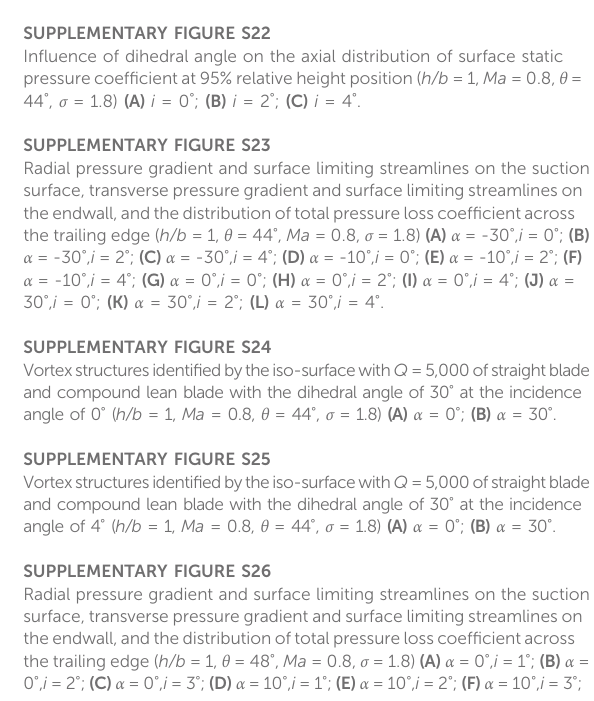
SUPPLEMENTARY FIGURE S16 In fl uence of solidity and dihedral angle on incidence characteristics of total pressure loss coef fi cient and diffusion factor with different camber angels ( h/b = 1, Ma = 0.8) (A) θ = 40 ° , α = 0 ° ; (B) θ = 40 ° , α = 20 ° ; (C) θ = 40 ° , α = 30 ° ; (D) θ = 44 ° , α = 0 ° ; (E) θ = 44 ° , α = 20 ° ; (F) θ = 44 ° , α = 30 ° ; (G) θ =48 ° , α =0 ° ; (H) θ =48 ° , α =20 ° ; (I) θ =48 ° , α =30 ° ; (J) θ =50 ° , α =0 ° ; (K) θ = 50 ° , α = 20 ° ; (L) θ = 50 ° , α = 30 ° . SUPPLEMENTARY FIGURE S17 Axial distribution of surface static pressure coef fi cient at 50% relative height position at different solidities ( h/b = 1, Ma = 0.8, θ = 44 ° ) (A) i = 1 ° ; (B) i = 2 ° . SUPPLEMENTARY FIGURE S18 Radial pressure gradient and surface limiting streamlines on the suction surface, transverse pressure gradient and surface limiting streamlines on the endwall, and the distribution of total pressure loss coef fi cient acrossthetrailingedge( h/b =1, θ =44 ° , Ma =0.8) (A) i =1 ° , σ =1.4; (B) i = 1 ° , σ = 1.8; (C) i = 1 ° , σ = 2.2; (D) i = 2 ° , σ = 1.4; (E) i = 2 ° , σ = 1.8; (F) i = 2 ° , σ = 2.2. SUPPLEMENTARY FIGURE S19 In fl uence of dihedral angle on incidence characteristics of total pressure loss coef fi cient with different camber angels ( h/b = 1, Ma = 0.8, (A) σ = 1.8) θ = 40 ° ; (B) θ = 44 ° ; (C) θ = 48 ° . SUPPLEMENTARY FIGURE S20 Radial pressure gradient and surface limiting streamlines on the suction surface, transverse pressure gradient and surface limiting streamlineson theendwall,andthedistributionoftotalpressurelosscoef fi cientacross the trailing edge ( h/b = 1, θ = 40 ° , Ma = 0.8, σ = 1.8) (A) α = 0 ° , i = 0 ° ; (B) α = 0 ° , i =2 ° ; (C) α =0 ° , i =4 ° ; (D) α =10 ° , i =0 ° ; (E) α =10 ° , i =2 ° ; (F) α =10 ° , i =4 ° ; (G) α = 20 ° , i = 0 ° ; (H) α = 20 ° , i = 2 ° ; (I) α = 20 ° , i = 4 ° ; (J) α = 30 ° , i = 0 ° ; (K) α = 30 ° , i = 2 ° ; (L) α = 30 ° , i = 4 ° . SUPPLEMENTARY FIGURE S21 In fl uence of dihedral angle on the spanwise distribution of total pressure losscoef fi cientacrossthetrailingedge( h/b =1, Ma =0.8, θ =44 ° , σ =1.8) (A) i = 0 ° ; (B) i = 2 ° ; (C) i = 4 ° . SUPPLEMENTARY FIGURE S22 In fl uence of dihedral angle on the axial distribution of surface static pressurecoef fi cientat95%relativeheightposition( h/b =1, Ma =0.8, θ = 44 ° , σ = 1.8) (A) i = 0 ° ; (B) i = 2 ° ; (C) i = 4 ° . SUPPLEMENTARY FIGURE S23 Radial pressure gradient and surface limiting streamlines on the suction surface, transverse pressure gradient and surface limiting streamlineson theendwall,andthedistributionoftotalpressurelosscoef fi cientacross the trailing edge ( h/b = 1, θ = 44 ° , Ma = 0.8, σ = 1.8) (A) α = -30 ° , i = 0 ° ; (B) α = -30 ° , i = 2 ° ; (C) α = -30 ° , i = 4 ° ; (D) α = -10 ° , i = 0 ° ; (E) α = -10 ° , i = 2 ° ; (F) α = -10 ° , i = 4 ° ; (G) α = 0 ° , i = 0 ° ; (H) α = 0 ° , i = 2 ° ; (I) α = 0 ° , i = 4 ° ; (J) α = 30 ° , i = 0 ° ; (K) α = 30 ° , i = 2 ° ; (L) α = 30 ° , i = 4 ° . SUPPLEMENTARY FIGURE S24 Vortexstructuresidenti fi edbytheiso-surfacewith Q =5,000ofstraightblade and compound lean blade with the dihedral angle of 30 ° at the incidence angle of 0 ° ( h/b = 1, Ma = 0.8, θ = 44 ° , σ = 1.8) (A) α = 0 ° ; (B) α = 30 ° . SUPPLEMENTARY FIGURE S25 Vortexstructuresidenti fi edbytheiso-surfacewith Q =5,000ofstraightblade and compound lean blade with the dihedral angle of 30 ° at the incidence angle of 4 ° ( h/b = 1, Ma = 0.8, θ = 44 ° , σ = 1.8) (A) α = 0 ° ; (B) α = 30 ° . SUPPLEMENTARY FIGURE S26 Radial pressure gradient and surface limiting streamlines on the suction surface, transverse pressure gradient and surface limiting streamlineson theendwall,andthedistributionoftotalpressurelosscoef fi cientacross the trailing edge ( h/b = 1, θ = 48 ° , Ma = 0.8, σ = 1.8) (A) α = 0 ° , i = 1 ° ; (B) α = 0 ° , i =2 ° ; (C) α =0 ° , i =3 ° ; (D) α =10 ° , i =1 ° ; (E) α =10 ° , i =2 ° ; (F) α =10 ° , i =3 °